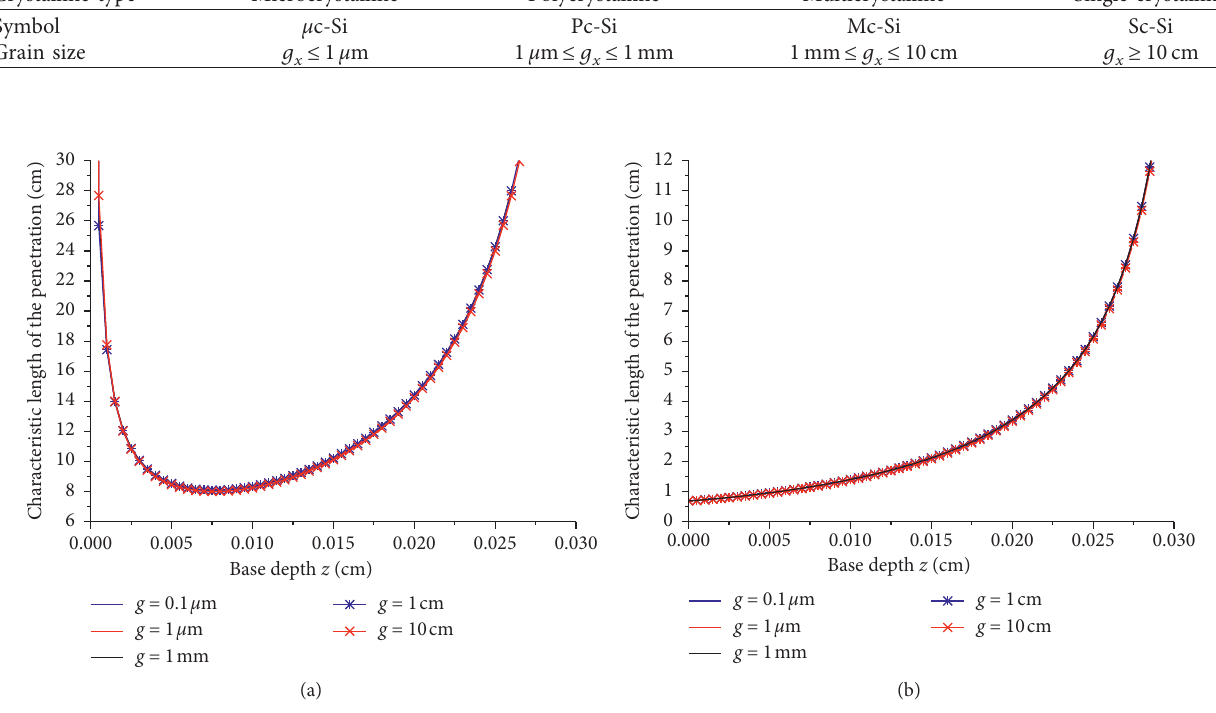
Figure 2: Characteristic length of the penetration against base depth for different grain sizes in (a) short circuit and (b) open circuit ( S gb � 10 3 cm s − 1 ). Table 2: Behaviour of radio waves in the vicinity of the junction in the short circuit. Crystalline type Single crystalline Comparison between l p and g Behaviour of the radio wave Table 3: Behaviour of radio waves inside the base of the polysilicon grain in the short circuit. Crystalline type Single crystalline Comparison between l p and g Behaviour of the radio wave